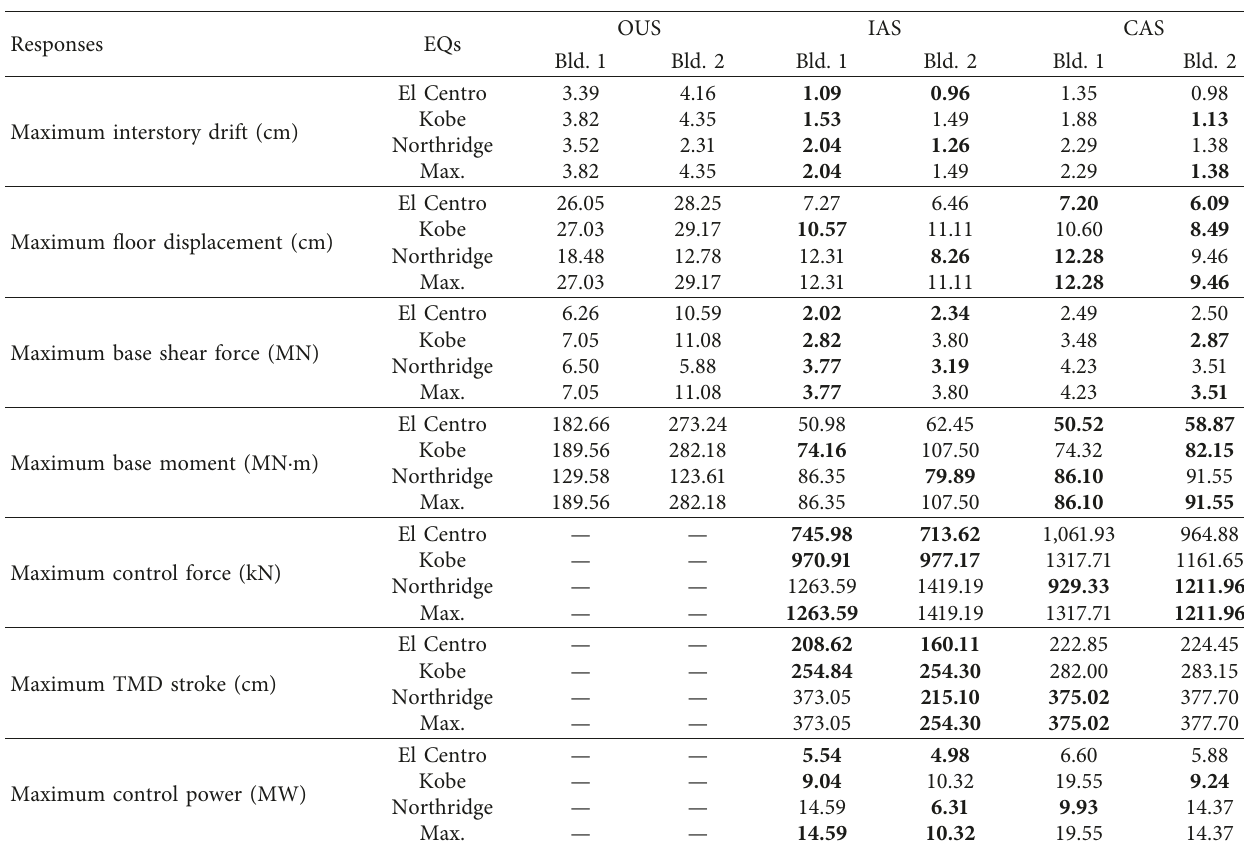
Figure 7: Comparative time-history curves of base overturning moment among OUS, IAS, and CAS against El Centro earthquakes. (a) Building 1. (b) Building 2. Table 5: Comparative results of seismic performances and control requirements among OUS, IAS, and CAS against three earthquake